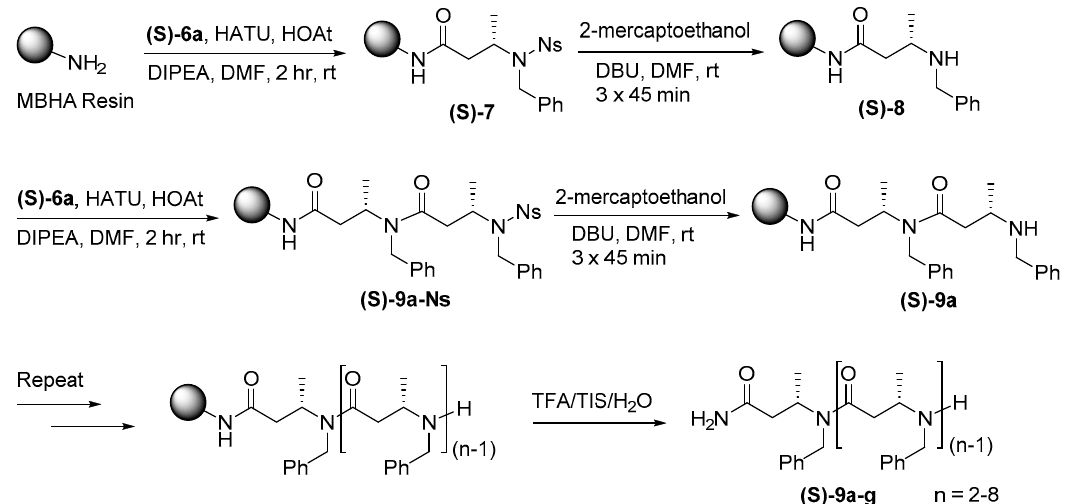
Molecules 2019 , 24 , x